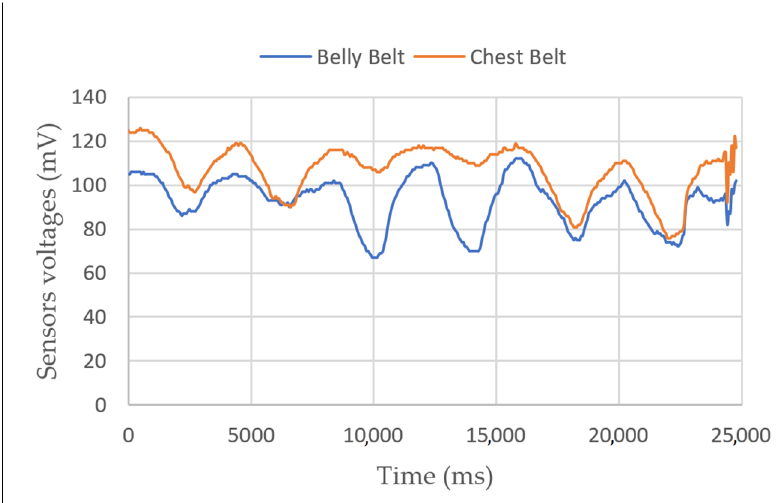
Figure 3. Belts sensors’ voltages vs. time. The figure shows 6 breathing cycles. The first two and last two breaths are performed with the belly and chest, and the middle two only with the belly.